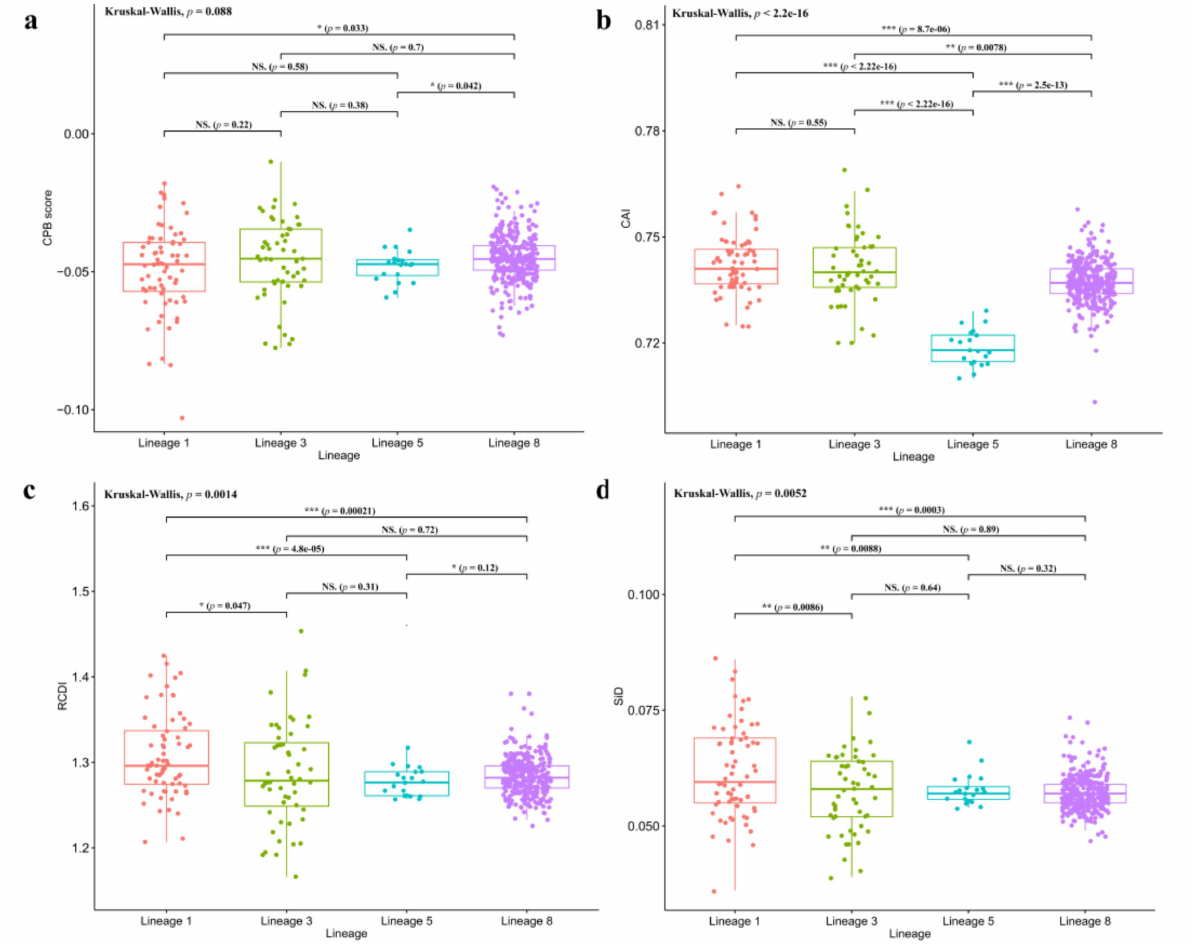
Figure 4. CPB scores ( a ), CAI ( b ), RCDI ( c ), and SiD ( d ) box-plots of ORF5 genes from different lineages of Chinese PRRSV strains. The asterisk indicates a significant difference between labeled groups (NS. 0.05 < p ; * 0.01 < p ≤ 0.05; ** 0.001 < p ≤ 0.01; *** p ≤